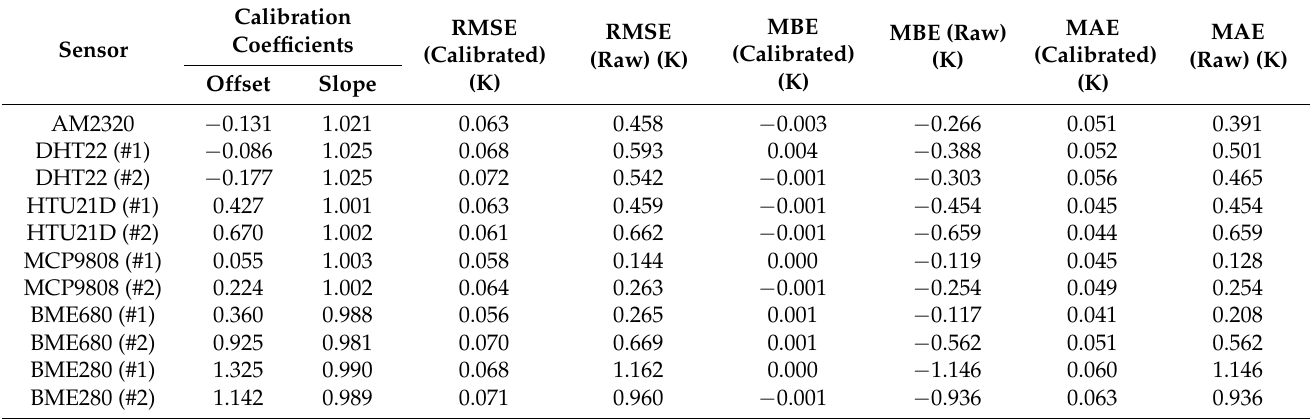
Table A1. Individual calibration coefficients (offset and slope), root mean square error (RMSE), mean bias error (MBE), and mean absolute error (MAE) for calibrated and raw values of all tested air temperature